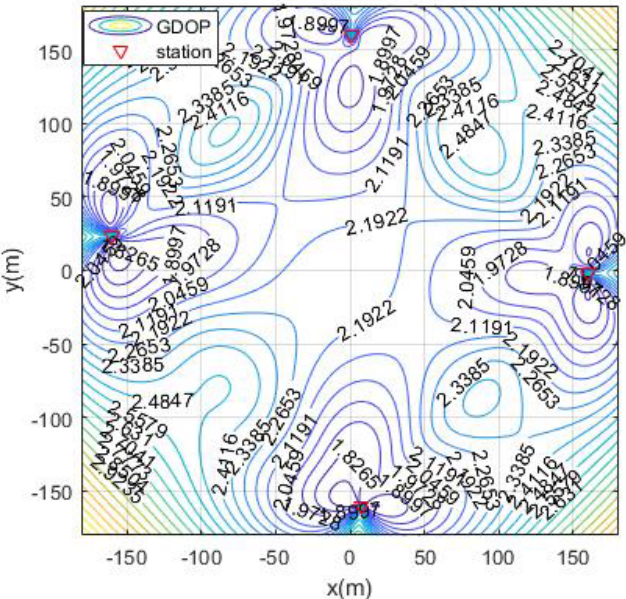
Figure 5. GDOP for coarse positioning by four detection devices.